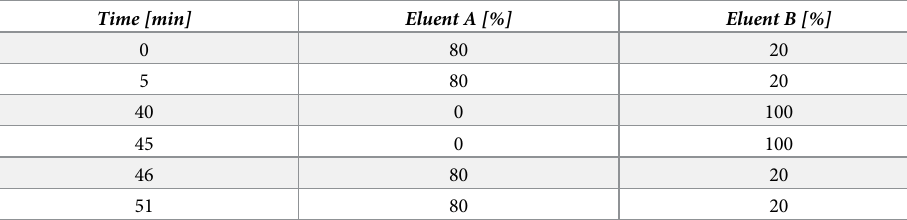
Table 1. Chromatographic method used for FcRn affinity chromatography. Time